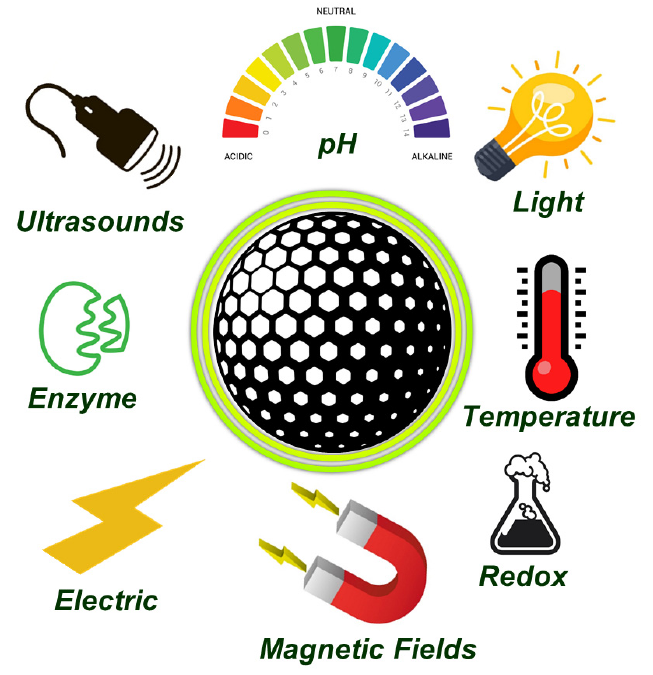
Figure 3. Schematic representation of loaded mesoporous silica nanoparticles surrounded by the different stimuli, both internal and external, that could be used to trigger the cargo release.